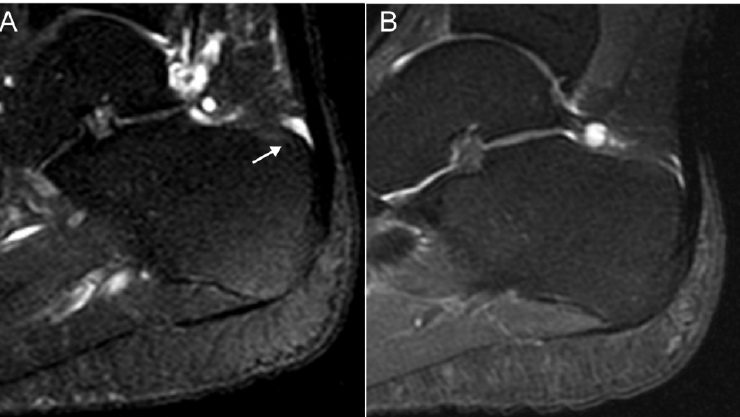
Figure 2. MRI images of a 48-year old female with ankylosing spondylitis, showing an increase in peri-Achilles tendon hypersignal after one-year longitudinal follow-up. ( A ) T2 SPAIR weighted image showing no hypersignal surrounding the Achilles tendon, ( B ) T2 SPAIR weighted image showing hypersignal (arrow: moderate; grade 2) surrounding the Achilles tendon, close to its insertion. Figure Legend: SPAIR = Spectral Selection Attenuated Inversion Recovery.